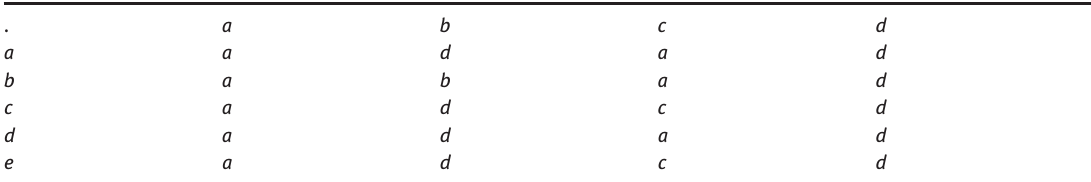
Table 1: Multiplication table of S = { a , b , c , d , e }.